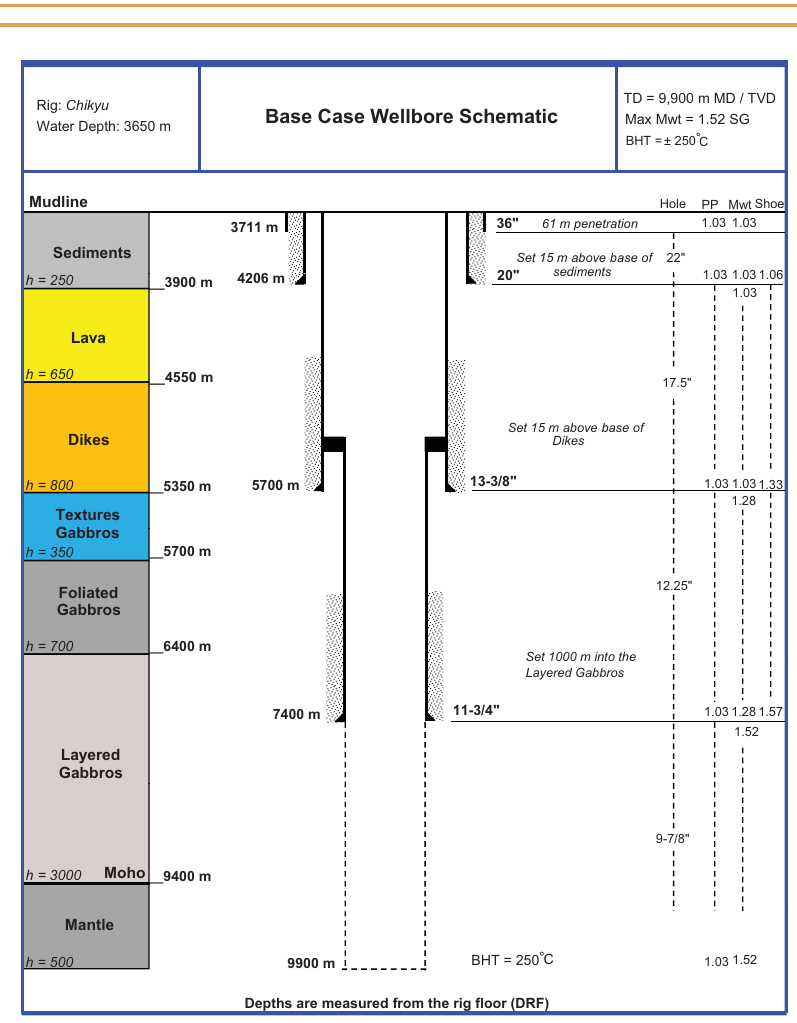
Figure 2. Riser tension requirements vs. mud weight for the current Chikyu drilling riser at the Hawaii location ( Chikyu Spec. 2008.pdf).